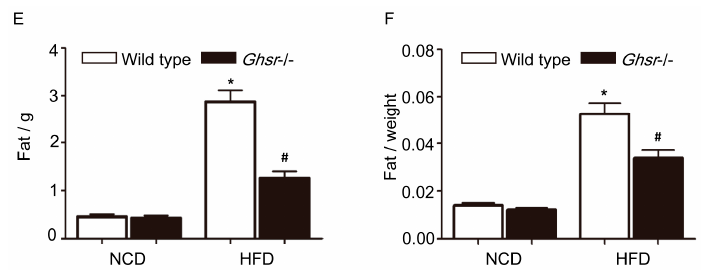
Figure 1. Phenotype of Ghsr − / − mice. Wild type or Ghsr − / − mice were fed with either normal chow diet (NCD) or 45% high fat diet (HFD) for 12 weeks. ( A ) Body weight change of wild type or Ghsr − / − mice fed with NCD or HFD. ( B – E ) Average daily food intake ( B ), average daily water intake ( C ), average body weight ( D ) or average weight variation of epididymal adipose tissue ( E ) of wild type or Ghsr − / − mice fed with NCD or HFD is shown. ( F ) The epididymal adipose tissue/body weight ratio in wild type or Ghsr − / − mice fed with NCD or HFD is shown. Data are expressed as mean ± SD, * denotes p < 0.05 compared with wild type mice fed with NCD, # denotes p < 0.05 as compared with wild type mice fed with HFD.